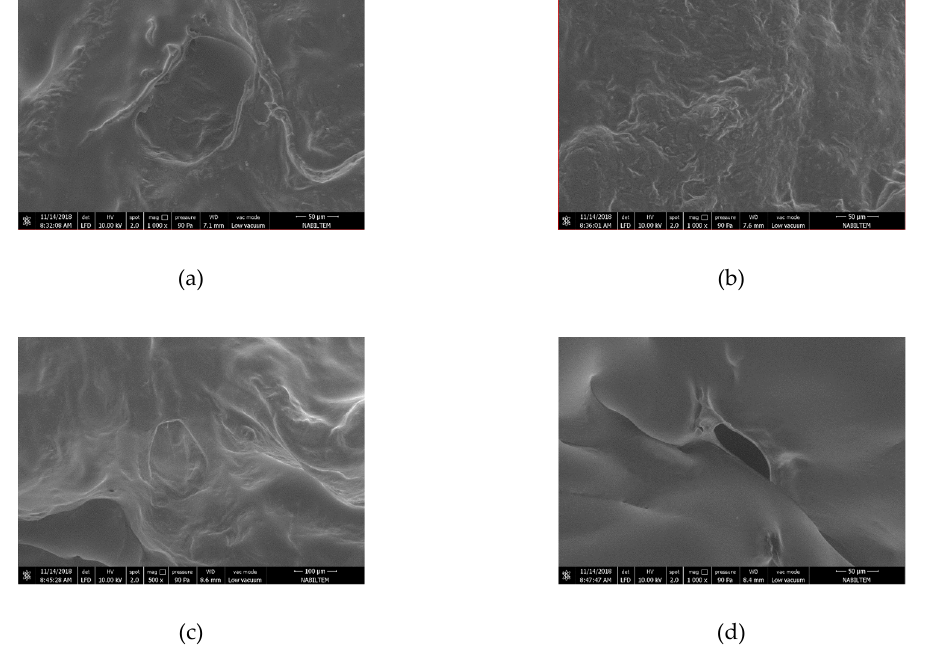
Figure 9. SEM (Scanning Electron Microscope) images of persimmon with 9 mm: ( a ) dried persimmon at 120 W; ( b ) dried persimmon at 350 W; ( c ) dried persimmon at 460 W; ( d ) dried persimmon at 600 W.